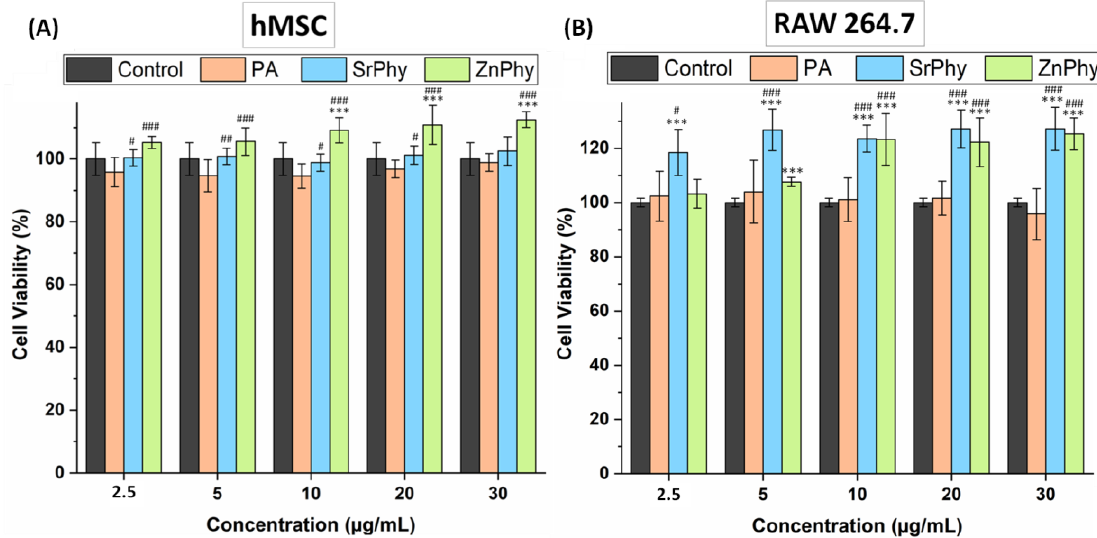
Figure 3. Cytotoxicity assessment of phytate compounds with ( A ) hMSC and ( B ) RAW264.7 cultures. An ANOVA was performed between PA, SrPhy and ZnPhy with control samples (basal-DMEM) (*** p < 0.001) and between SrPhy and ZnPhy relative to PA (# p < 0.05, ## p < 0.005, ### p < 0.001) at each concentration in both cases (Tukey’s means comparison). The results are displayed as the mean value (%) ± SD ( n = 8).